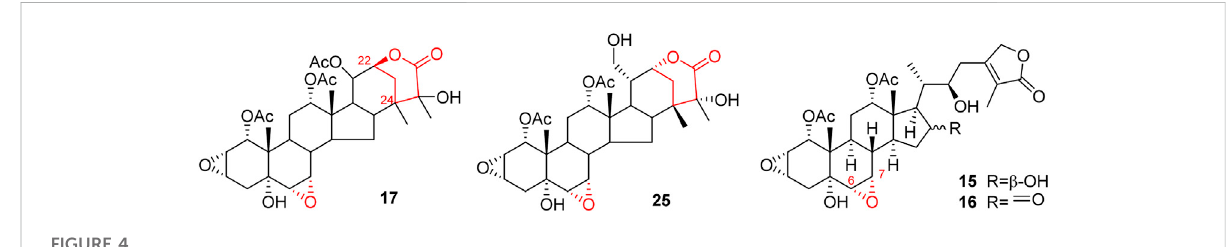
FIGURE 4 Structures of taccalonolides with lactone ring at C22 – C24 and